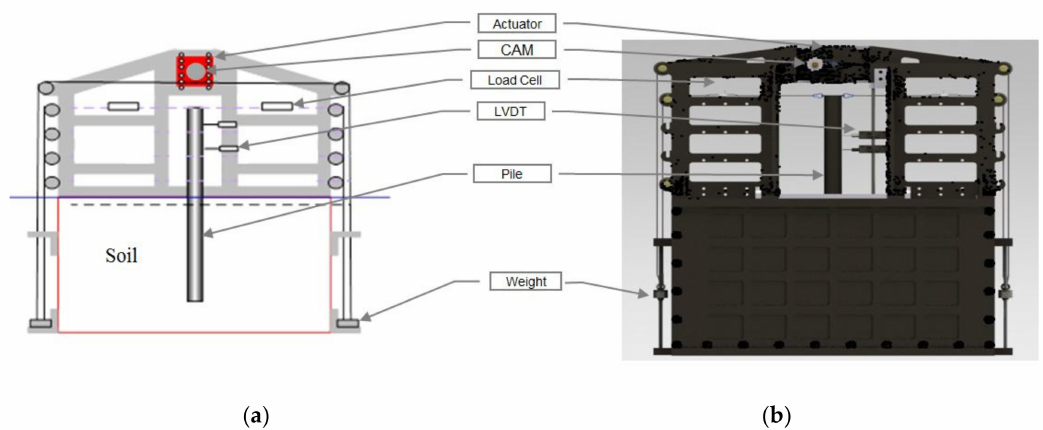
Figure 4. ( a ) Cyclic loading system design. ( b ) Cyclic lateral loading device.